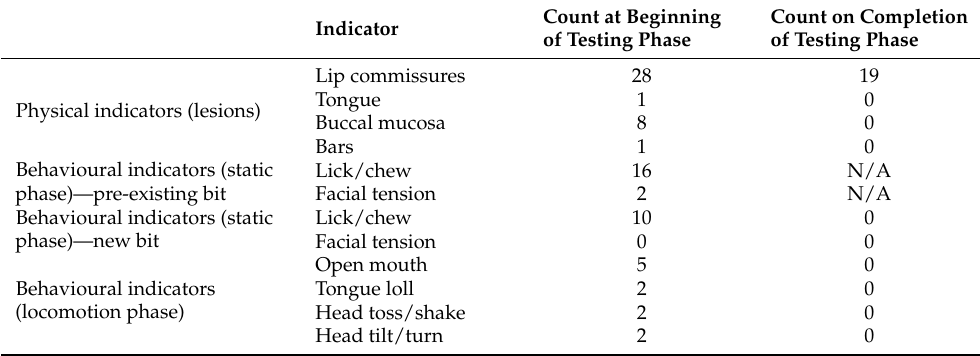
Table 4. Physical and behavioural indicator prevalence at beginning and end of testing phase ( n = 30).